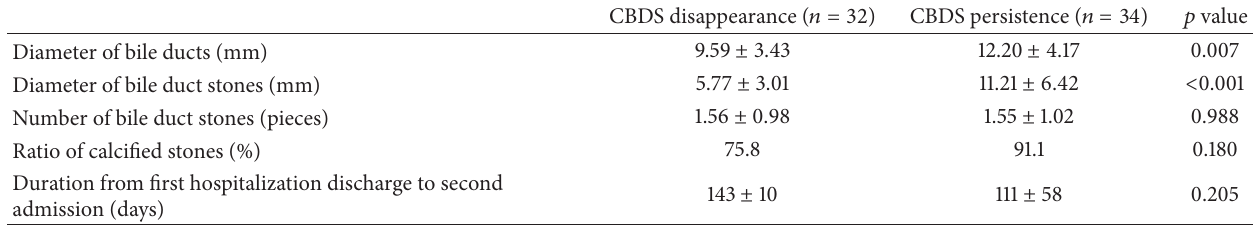
Table 3: Analysis of factors associated with stone disappearance and persistence ( 𝑛 = 66 ).